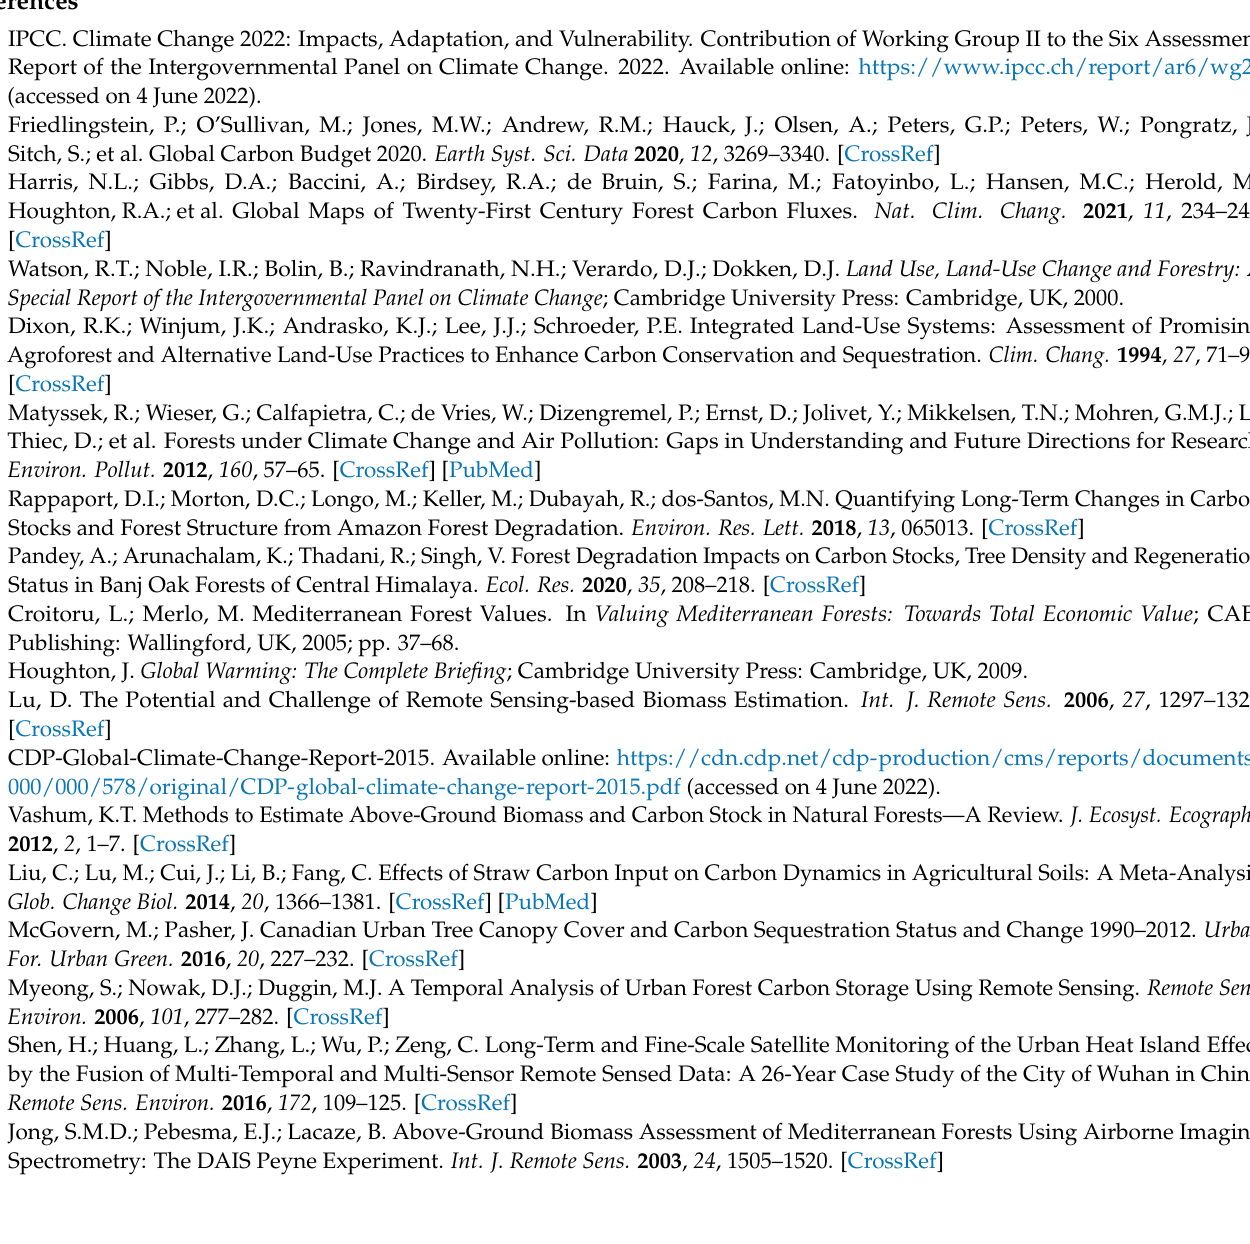
where B tree-BLG is the belowground biomass of an individual tree in kg and D 1.30m is the diameter at breast height (1.30 m) in